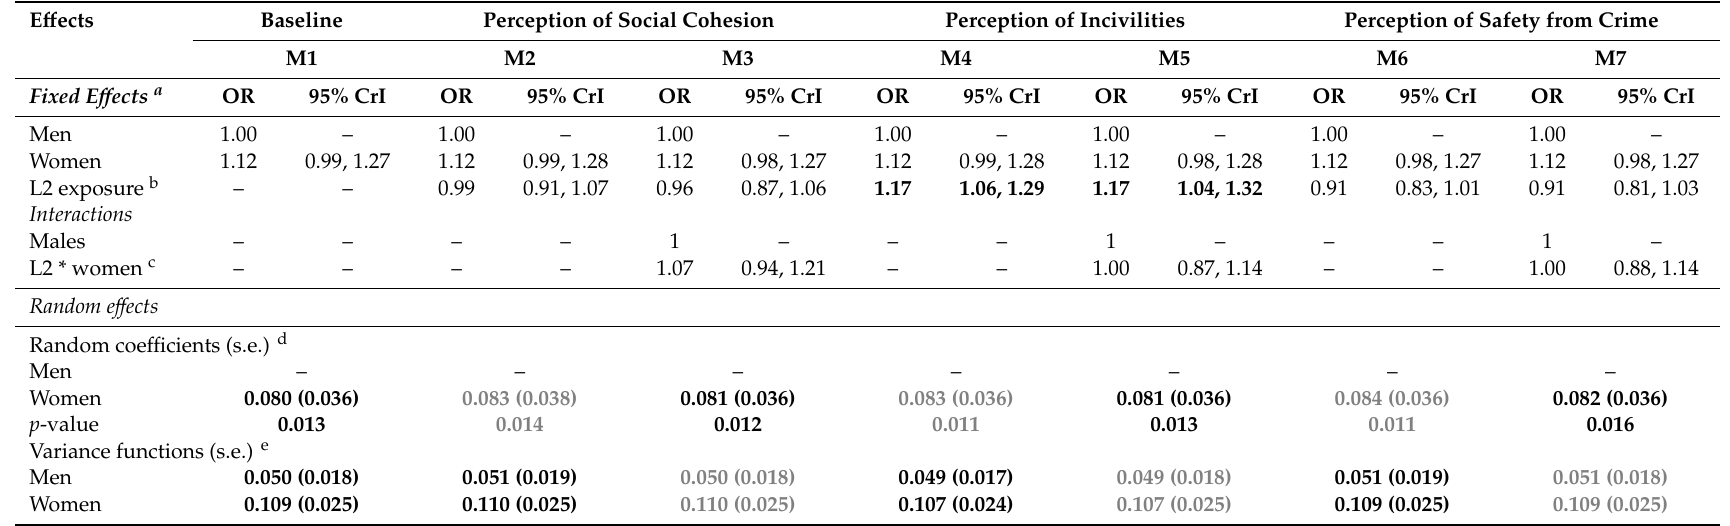
Table 2. Gender di ff erences in recreational walking, variation of this relationship across neighbourhoods, and the contribution of the social environment to explaining this